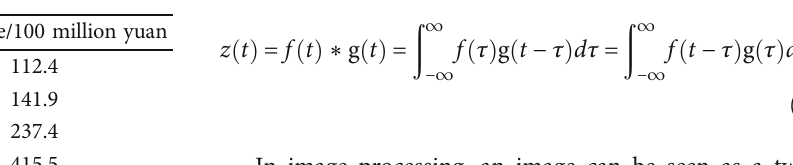
Table 1: China ’ s arti fi cial intelligence industry market scale from 2015 to